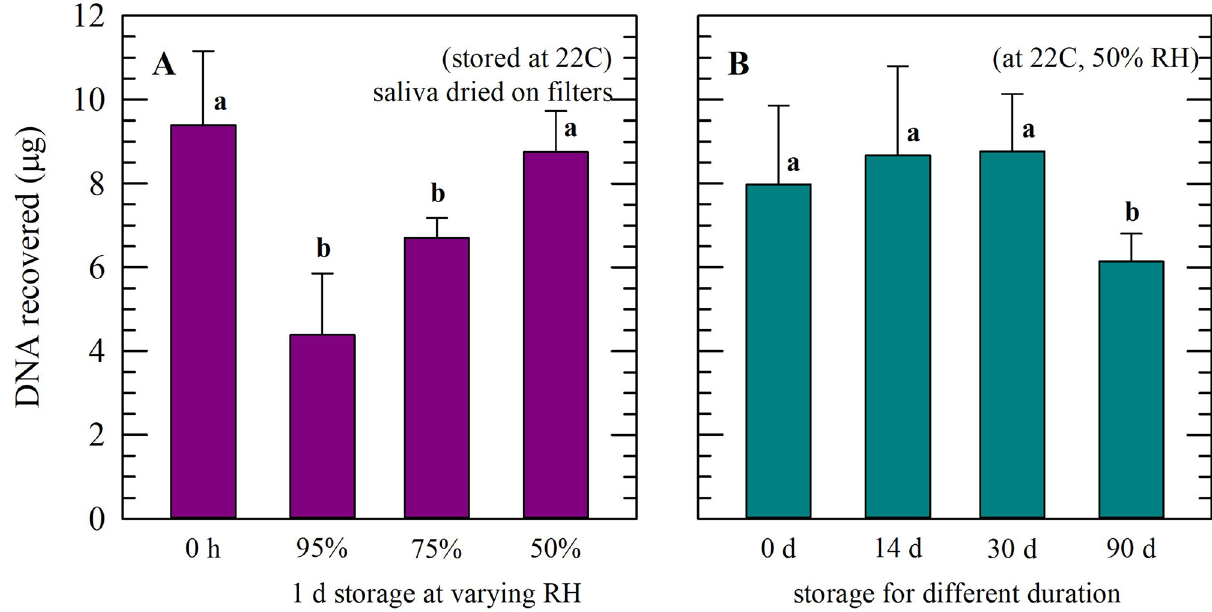
Figure 3. DNA recovery of saliva samples (250 µL), after drying on filters and storage under different conditions. Recovered DNA contents were determined before and after 1 d storage at different relative humidity conditions ( A ; 50%, 75%, and 95% RH), as well as after storage under ambient conditions (22 °C, 50% RH) for different durations ( B ; 0, 14, 30, and 90 d). Pooled saliva was used from three different donors. Measurements were performed in triplicate, and mean values ± standard deviations are presented. Different letters represent significant differences between storage conditions/storage times ( p ≤ 0.05) as determined using a one-way ANOVA